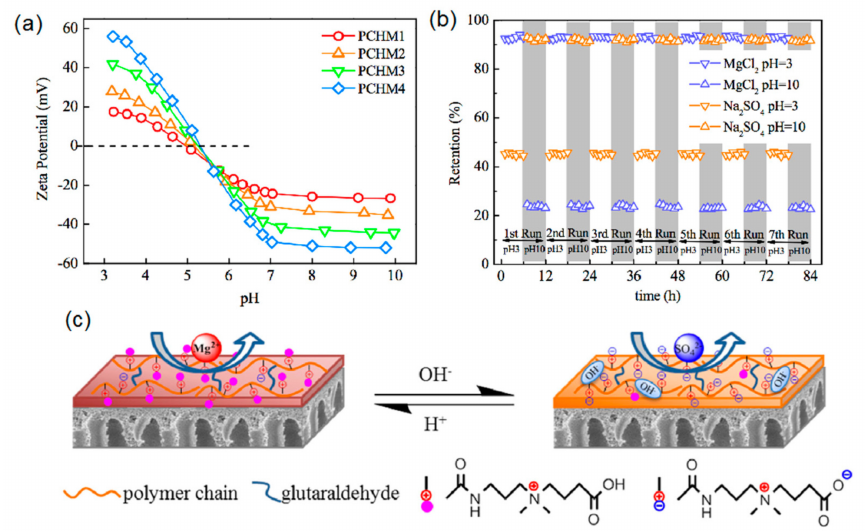
Figure 6. ( a ) Zeta potential varies with the pH of poly(carboxybetaine methacrylamide- co - N -(hydroxymethyl) acrylamide) membranes (PCHMs) tested with 1.0 mmol L − 1 KCl aqueous solution at 25 ◦ C; ( b ) Reversible change of retention of PCHM3 tested with 1 g L − 1 MgCl 2 and Na 2 SO 4 under feed pH value oscillating between 3.0 ( ∇ ) and 10.0 ( ∆ ) at 25 ◦ C and 0.6 MPa (the washing time was not counted in the plot); ( c ) The schematic model for pH responsibility of PCHMs. Reproduced with permission from Reference